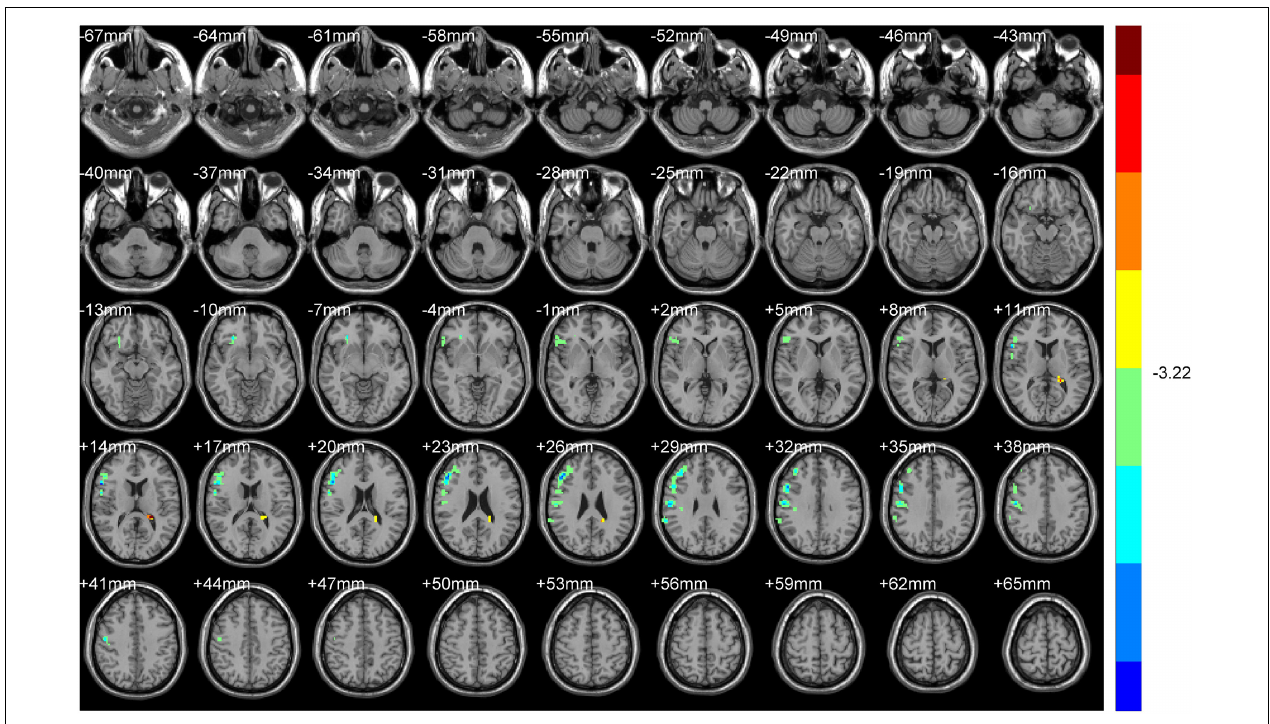
FIGURE 3 | ReHo (Dominant hemisphere vs. Normal). TABLE 3 | Regions of NDH showing significant changes in ALFF and ReHo values compared with HS. Parameter Effect Brain region MNI